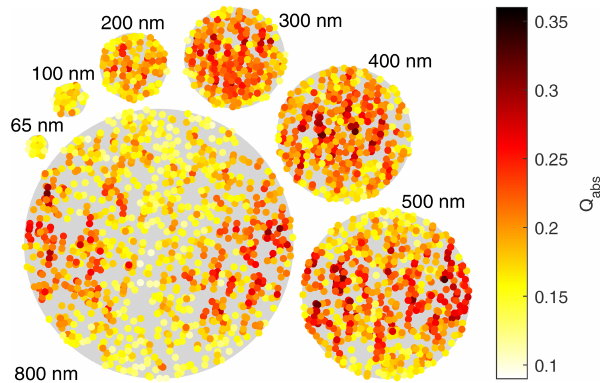
Figure B2. Light absorption by individual spherules in the model fullerene soot particles from the MSTM calculations. The laser beams are traveling left and right. Each particle illustration shows a 40nm slab through the middle of the particle. The yellow to red colors indicate relative light absorption rates, while the gray back- grounds show the mobility diameter. The low effective densities as found by Gysel et al. (2011) are particularly obvious in the large